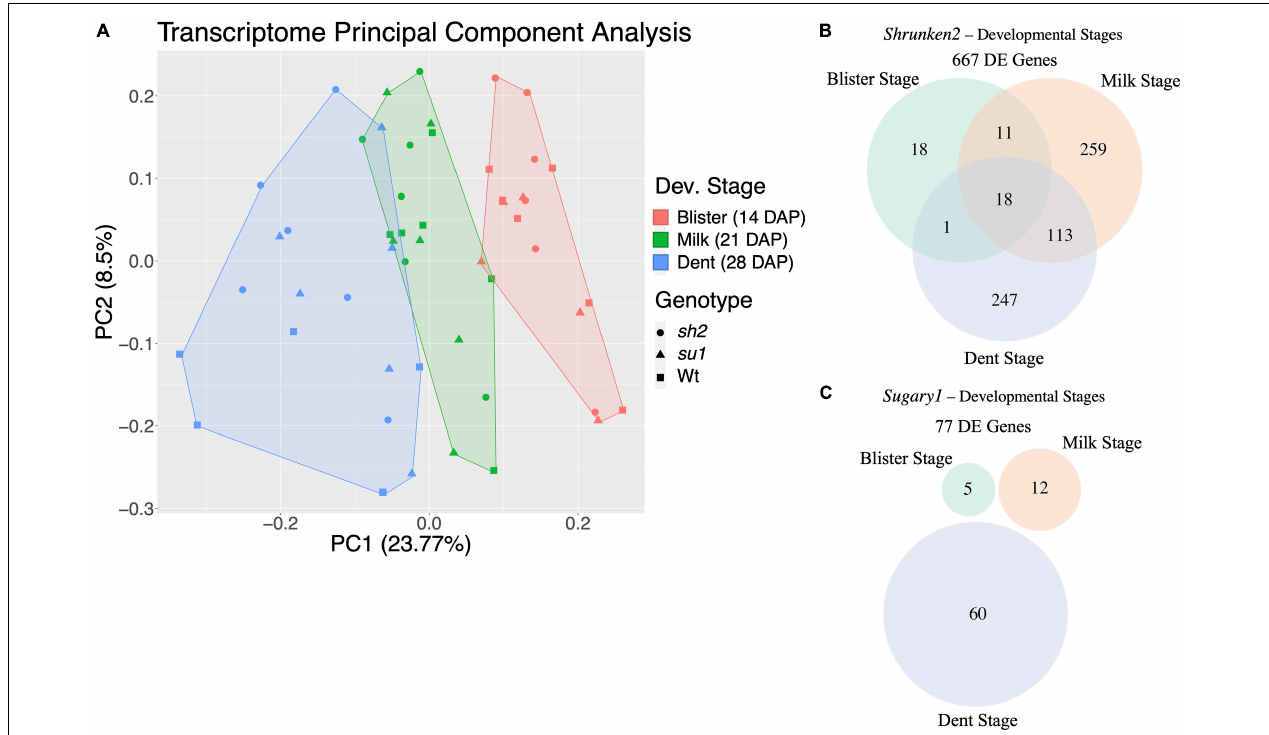
FIGURE 2 | Transcriptome/DE summary. (A) Clusters of samples from different mutant endosperm over developmental time identified by principal component analysis of gene expression levels. Colors represent timepoints while shapes indicate mutant. (B) Venn diagram of DEGs in sh2 endosperm at different timepoints. (C) Venn diagram of DEGs in su1 endosperm at different timepoints.